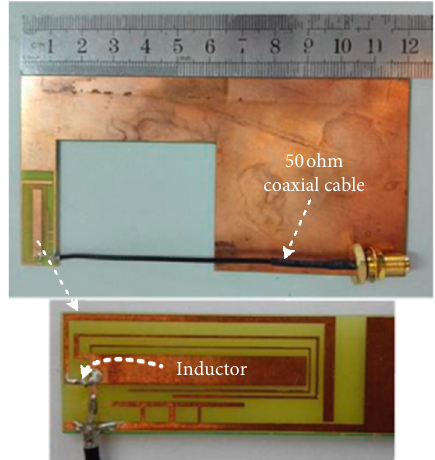
Figure 5: Photograph of the antenna.